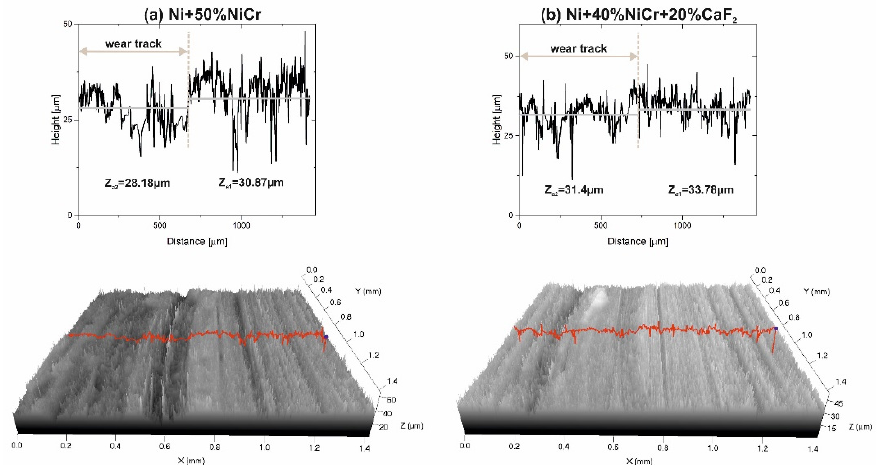
Figure 13. Stereometrics profiles of the counter-samples combined with Ni-50%NiCr(80/20) ( a ) and Ni-40%NiCr(80/20)-20%CaF 2 ( b ), after wear test at 600 °C.